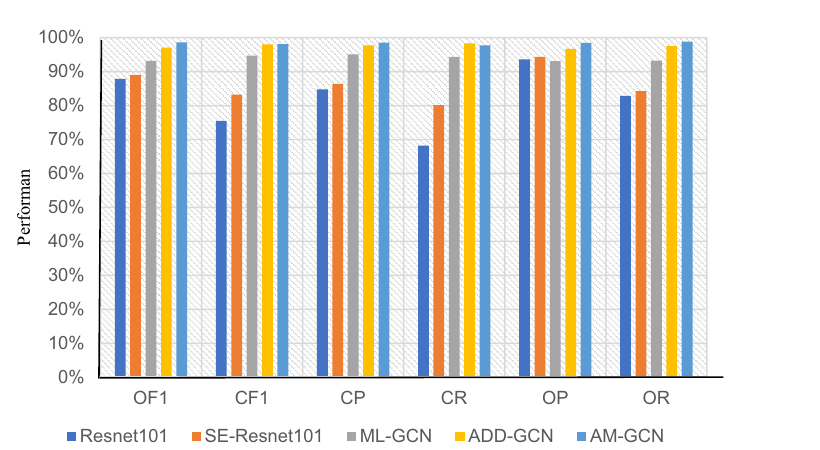
Figure 7. Comparison results of different indexes.